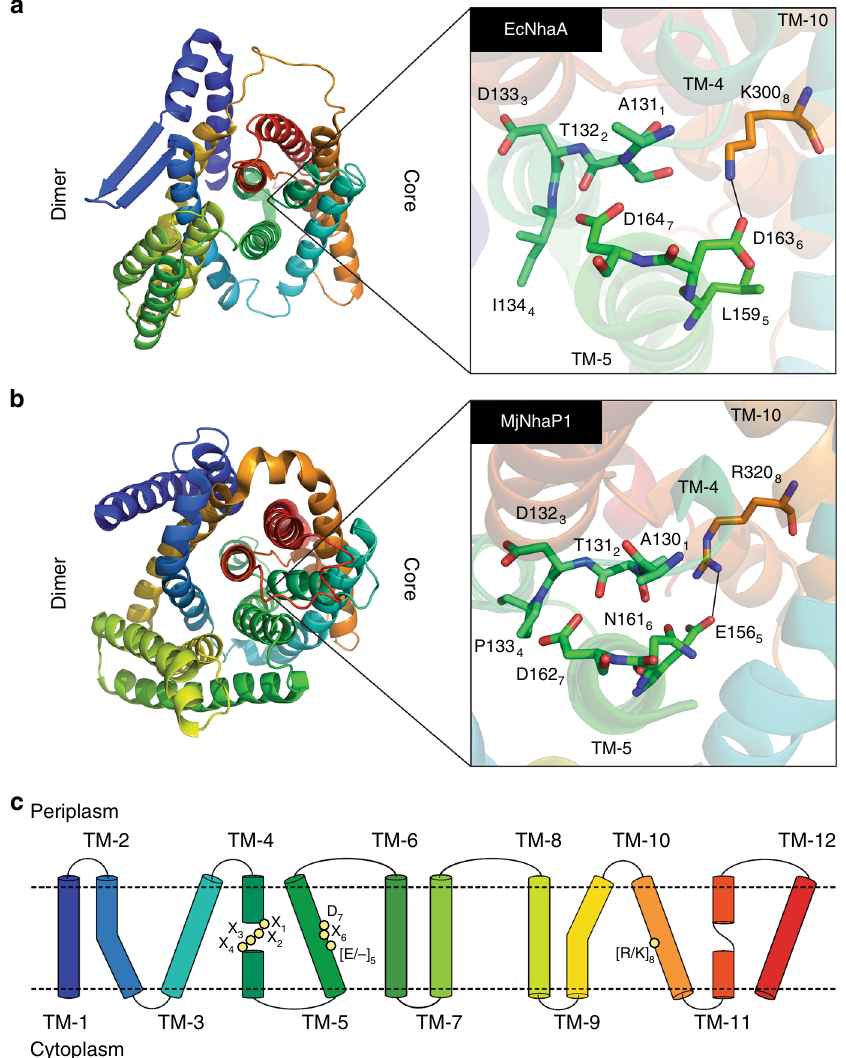
Fig. 3 The CPA motif is located in the core domain, near the ion binding site. a Periplasmic view of the electrogenic EcNhaA, showing the dimerization domain to the left and core domain to the right. The frame to the right displays a close-up view of the motif. The eight residues of the motif are shown using sticks representation, each with its sequence number and corresponding position in the motif (subscript). Their respective helices are designated in italics, and the conserved polar interaction between TM-5 and TM-10 is marked with a solid line. b The electroneutral MjNhaP1, shown as in a . The numbered residues correspond to their equivalents in EcNhaA. For example, D132 and E156 in MjNhaP1 correspond to D133 and L159 in EcNhaA, respectively. c Schematic two-dimensional representation of EcNhaA ’ s structure. The membrane boundaries are shown as dashed lines, the helices are numbered TM-1- through-TM-12, and the motif residues are indicated with yellow